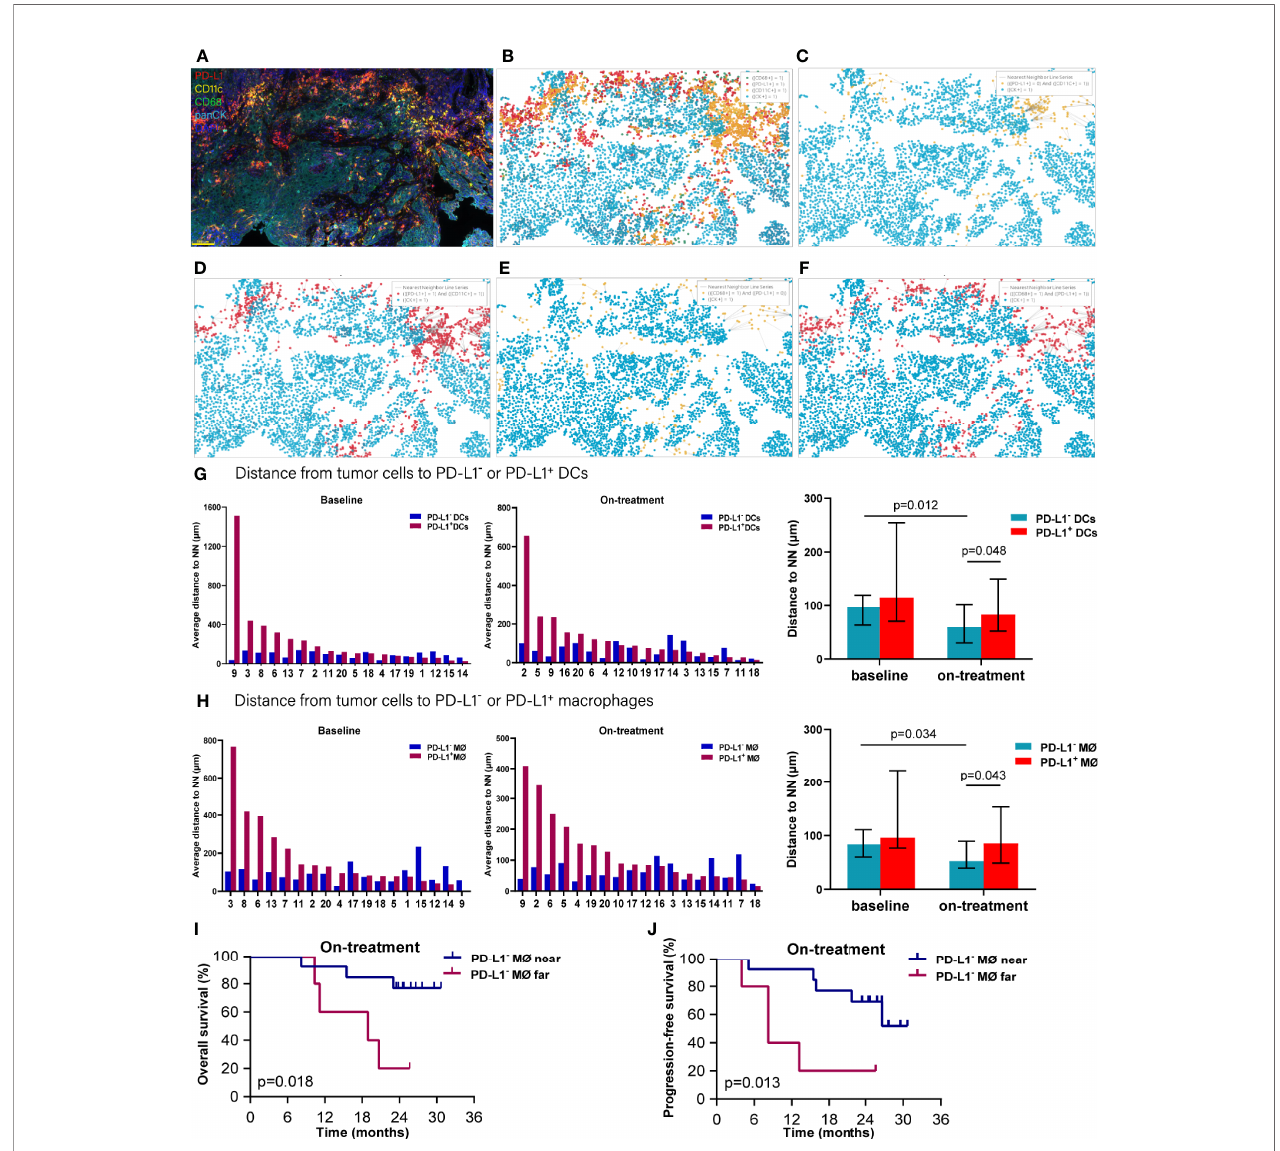
FIGURE 3 | Distance from tumor cells to the nearest dendritic cells and macrophages. (A) Representative multiplex multi-immuno fl uorescence image (case N14, before treatment) showing staining for CD11 (yellow), CD68 (green), PD-L1 (red), and CK (cyan). (B) Cellular phenotype map of image shown in A depicting the locations of CK + tumor cells (cyan dots), PD-L1 + (red dots), CD11c + dendritic cells (orange dots), and CD68 + macrophages (green dots). (C) Ray plot depicting the distance from each CK + tumor cell to the nearest PD-L - dendritic cells. (D) Ray plot depicting the distance from each CK + tumor cell to the nearest PD-L + dendritic cells. (E) Ray plot depicting the distance from each CK + tumor cell to the nearest PD-L - macrophages. (F) Ray plot depicting the distance from each CK + tumor cell to the nearest PD-L + macrophages. (G, H) Distances from tumor cells to the nearest PD-L1 - and PD-L1 + dendritic cells (G) and macrophages (H) for all patients with available tumors at baseline and during treatment. (I, J) Kaplan – Meier curves showing overall survival (I) and progression-free survival (J) based on distance from tumor cells to the nearest PD-L1 - macrophages during treatment. The tumors are ordered by the percentage of PD-L1 + dendritic cells or macrophages, from highest to lowest. Cutoff: (I) 83.454 m m; (J) 83.454 m m. On-treatment, after 40 Gy radiation. p ≤ 0.05, statistically signi fi